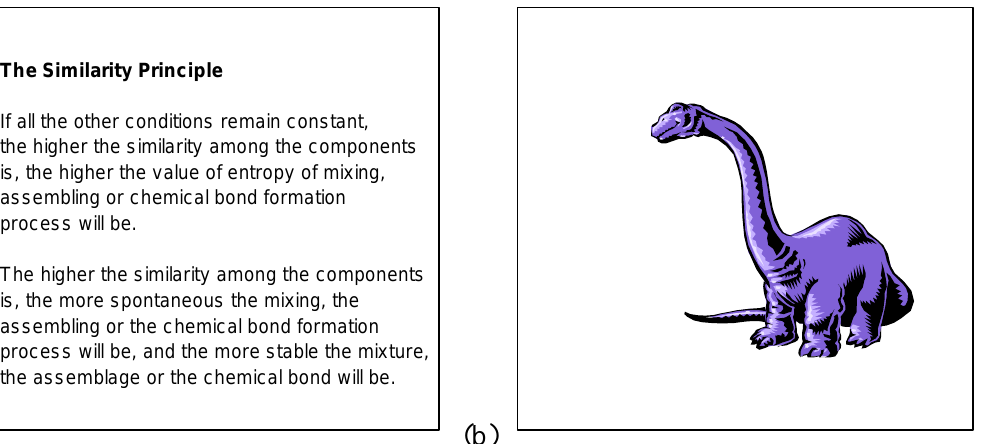
Figure 7. A static structure with certain text (a) and graphic (b) information recorded must have dramatically reduced